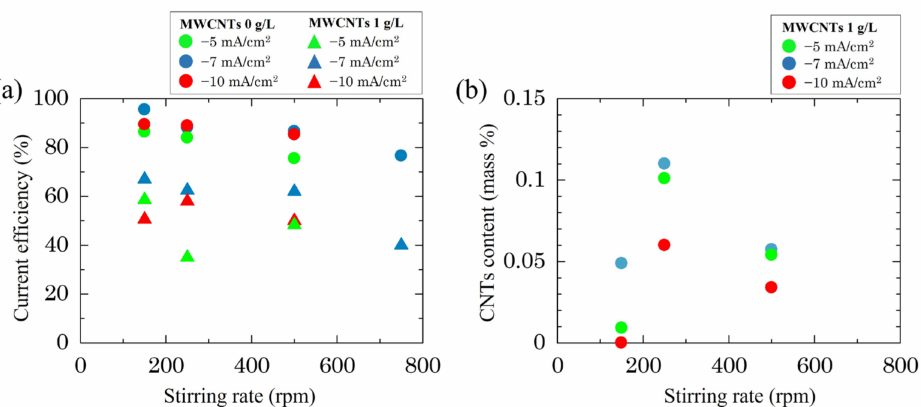
Figure 7. ( a ) Effect of the stirring rate on the current efficiency of Cu and Cu/CNT platings; and ( b ) CNT content of Cu/CNT composite platings at various stirring